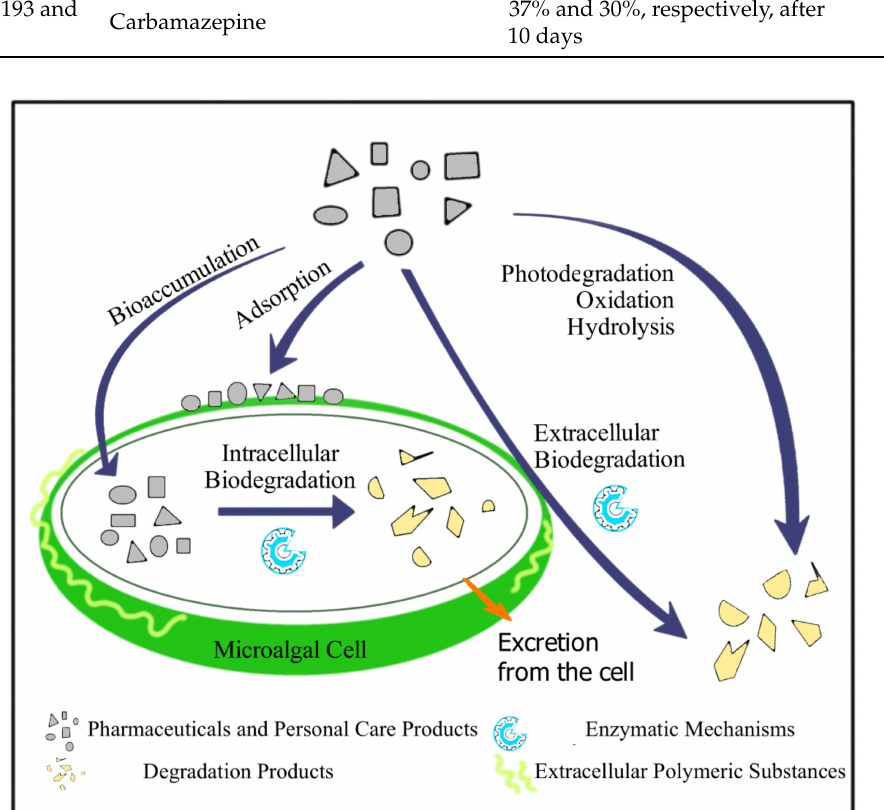
Figure 2. Processes involved in the removal of PPCPs using microalgae-based technologies. The removal of cephalosporin by microalgae, for example, is mediated by processes such as hydrolysis, photolysis, and biosorption [40]. However, Della Greca et al.